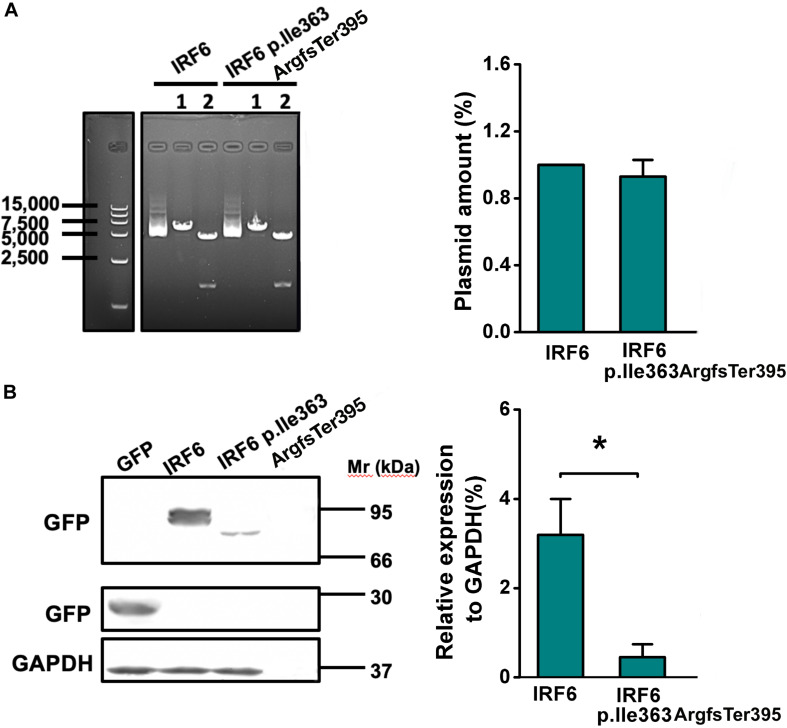
The frameshift of IRF6 at Ile363ArgfsTer395 causes reduced protein abundance level. (A) The plasmids expressing GFP-tagged versions of wildtype IRF6 and IRF6 p.Ile363ArgfsTer395 perform equal quantities. 1: single enzyme-cut linear plasmid; 2. Double enzyme-cut linear plasmid. (B) IRF6 p.Ile363ArgfsTer395 abundance levels were consistently seven- to eight-fold lower than those for WT IRF6. The difference was significant (*P < 0.05).